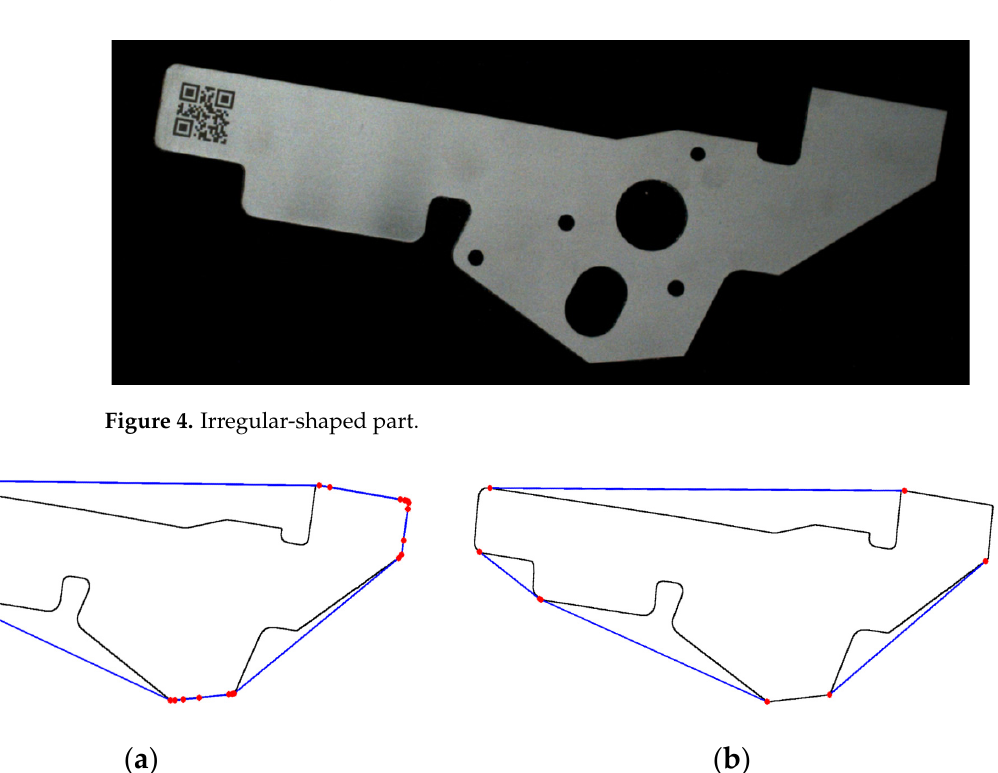
method is Z = { z i } ( i = 1, 2, 3, . . . , K ) , and the optimized segmentation results and convex hull are shown in Figure 5b.